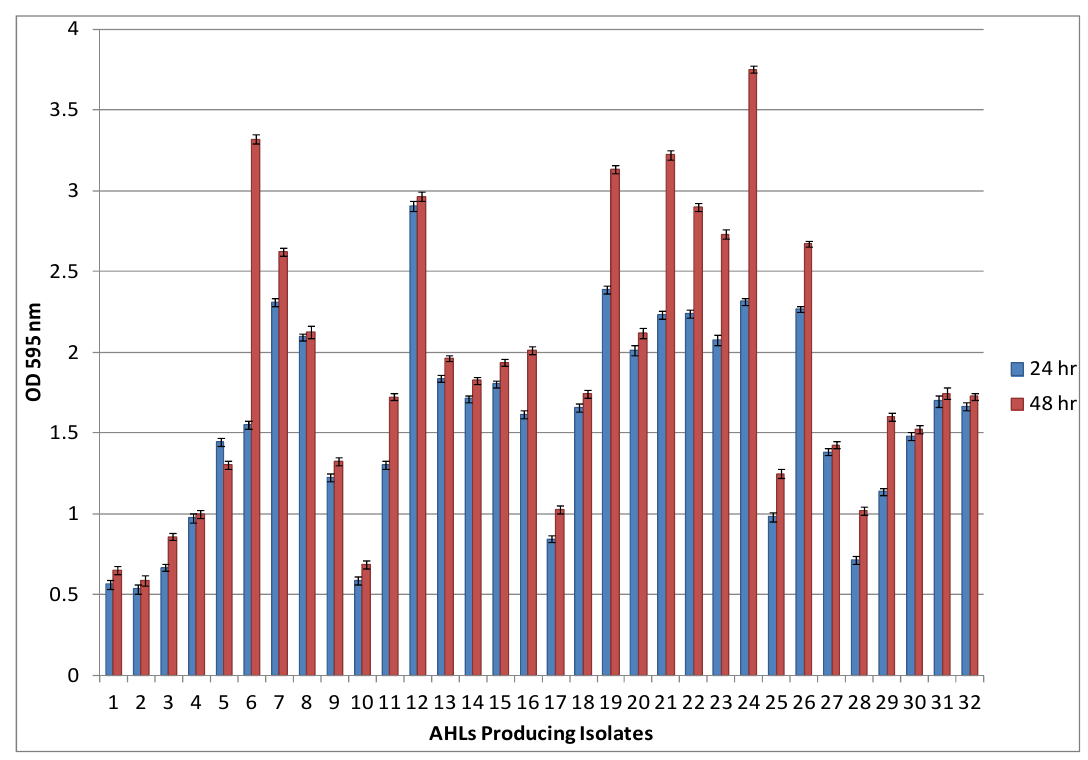
Figure 3. Biofilm formation among the AHLs producing bacteria as accessed by microtiter plate assay. The values are expressed as mean of four experiments and error bars indicates the standard